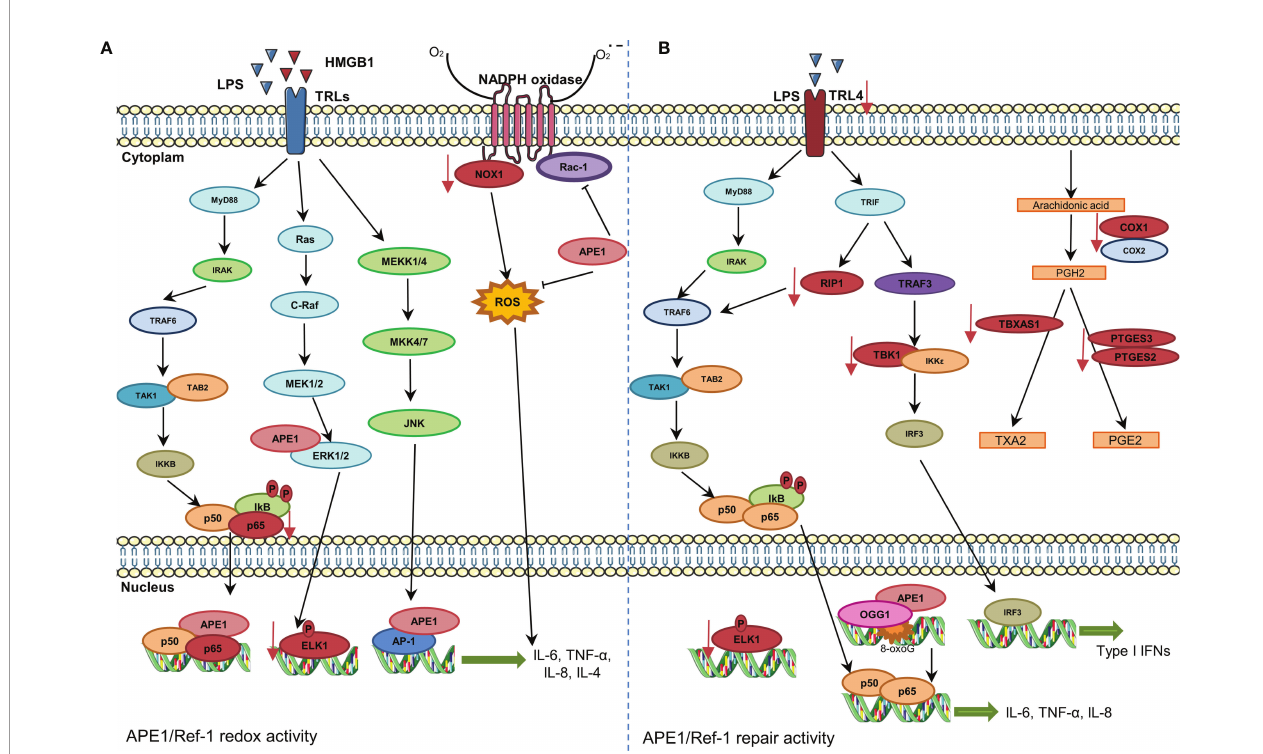
FIGURE 2 | Involvement of APE1 in expression of cytokines and chemokines and reactive oxygen species (ROS) regulation. (A) The stimulation of Toll-like receptors promotes NF- k B activation and its translocation to the nucleus. APE1 redox function reduces transcription factors, such as NF- k B and AP-1, and increases expression of cytokines. APE1 also inhibits Rac1 and ROS production by NADPH oxidase. Inhibition of APE1 redox function decreases the expression of NOX1, P65, and ELK1 (represented in red color). (B) The DNA repair activity of APE1 also regulates expression of cytokines. 8-Oxoguanine DNA glycosylase and APE1 recruitment to damaged sites is essential for downstream recruitment of transcription factors. Additionally, inhibition of APE1 DNA repair activity decreases the expression of various genes/proteins (represented in red